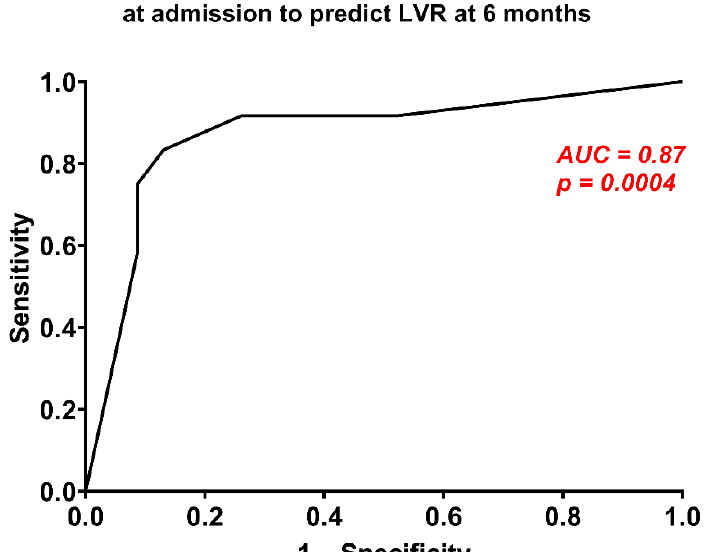
Figure 3. Combination of the concentrations of extracellular vesicles (EVs) from endothelial cells, erythrocytes and platelets based on the cut-offs to predict left ventricular remodelling (LVR) after AMI.